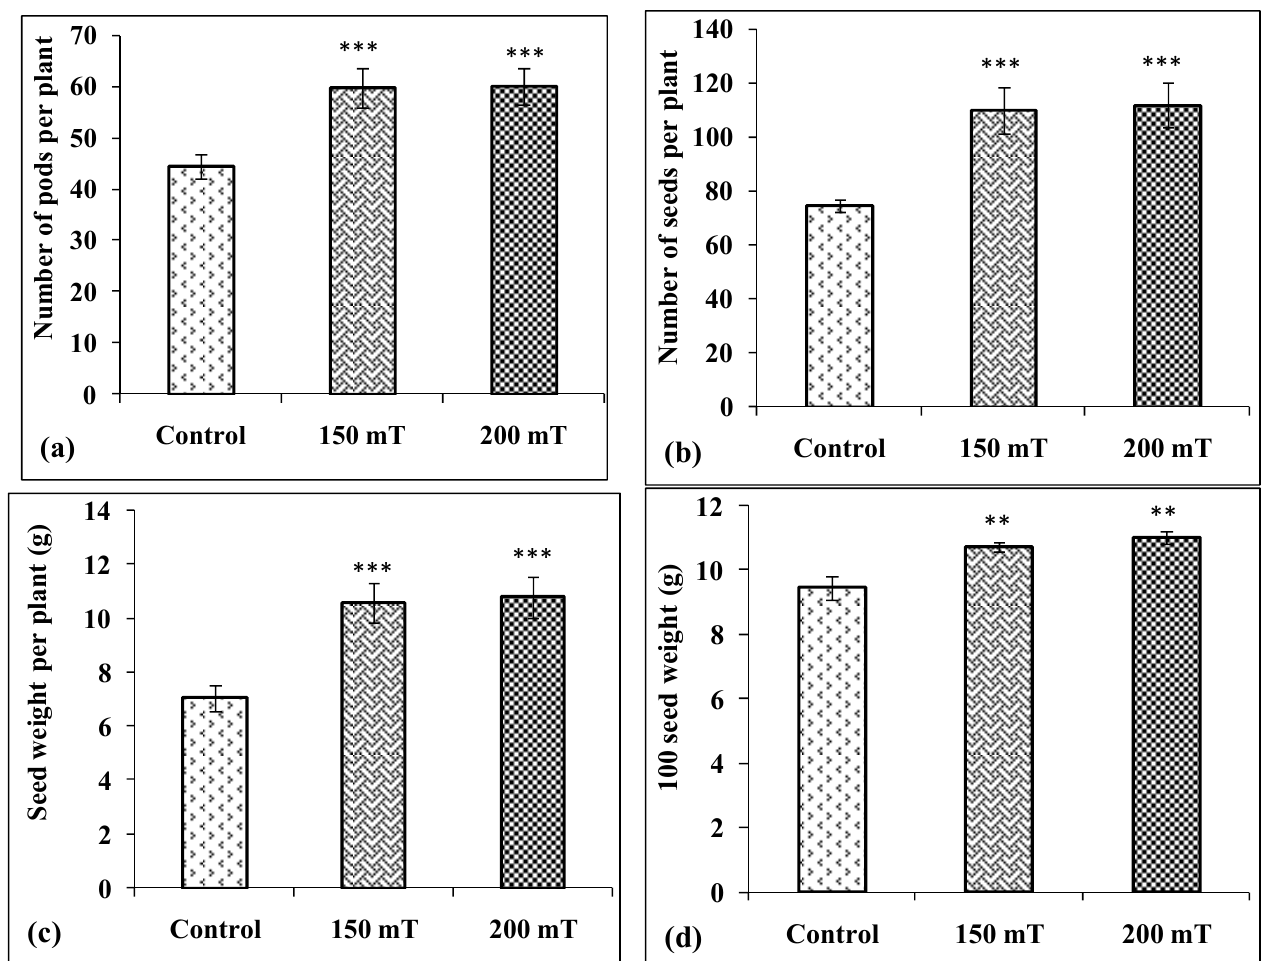
Figure 20. Effect of pre-sowing exposure of soybean seeds to magnetic field on yield attributes: number of pods per plant ( a ), number of seeds per plant ( b ), seed weight per plant ( c ), and 100 seed weight ( d ). *** and ** indicate significance at p < 0.001 and 0.01, respectively, compared to control.